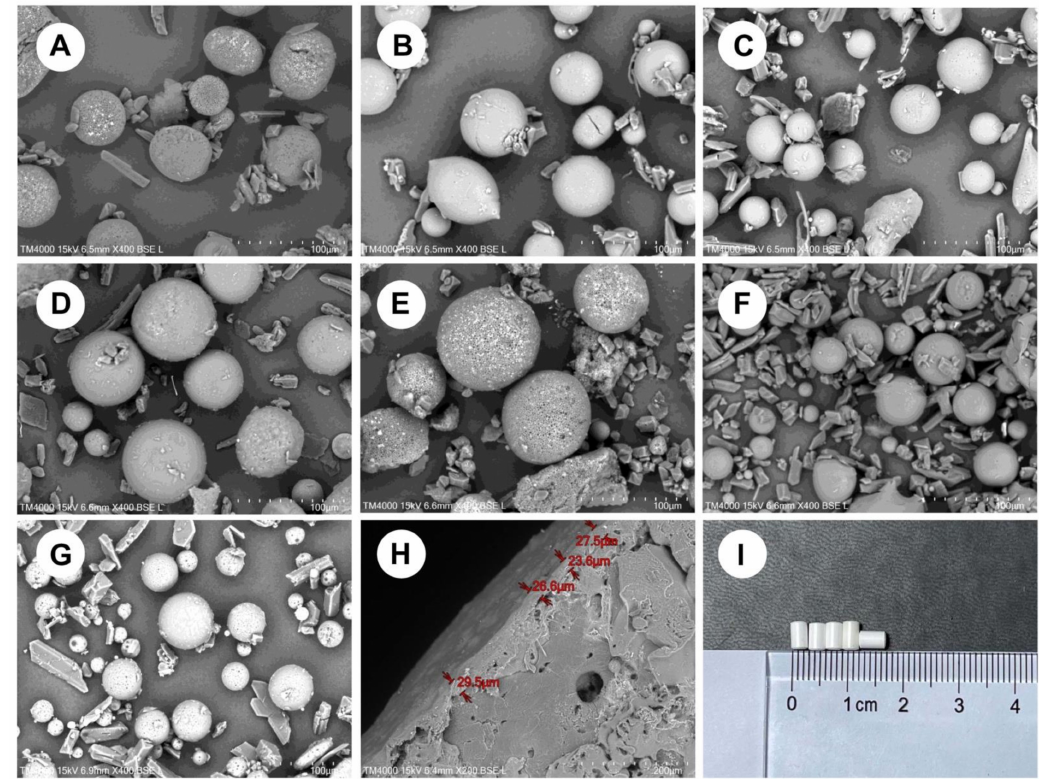
Figure 1. Electron micrographs of microspheres prepared with different formulations: ( A ) F1; ( B ) F2; ( C ) F3; ( D ) F4; ( E ) F5; ( F ) F6; ( G ) the optimized formulation; ( H ) the transverse section of the implant of the optimized formulation, and ( I ) the appearance of the optimal formulation implant.